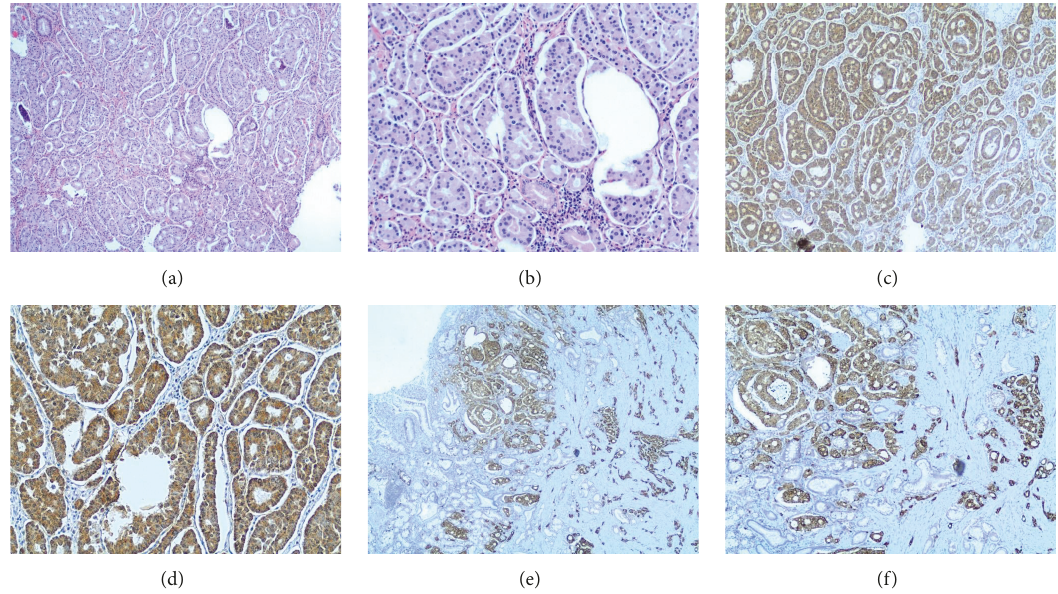
Figure 3: Histopathology images H&E [4x (a) and 0x (b)] reveal ampullary neuroendocrine tumor infiltrating the mucosa, submucosa, and muscularis propria with angiolymphatic invasion. Immunohistochemical stain images are positive for somatostatin [4x (c) and 10x (d)], and synaptophysin [2x (e) and 4x